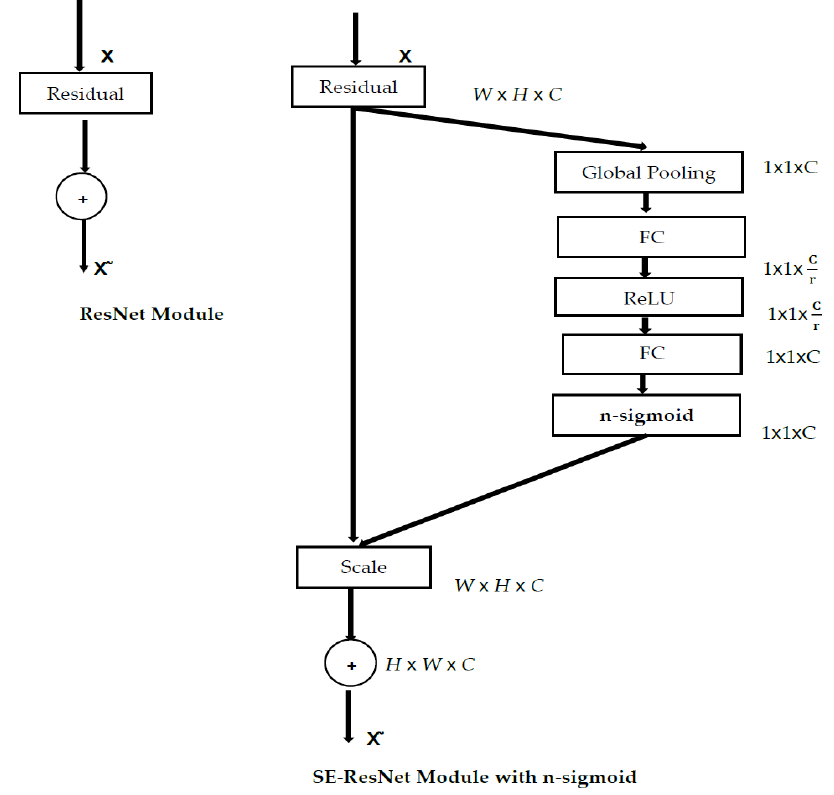
Figure 2. The schematic of the ResNet module using an SE block with an n-sigmoid .